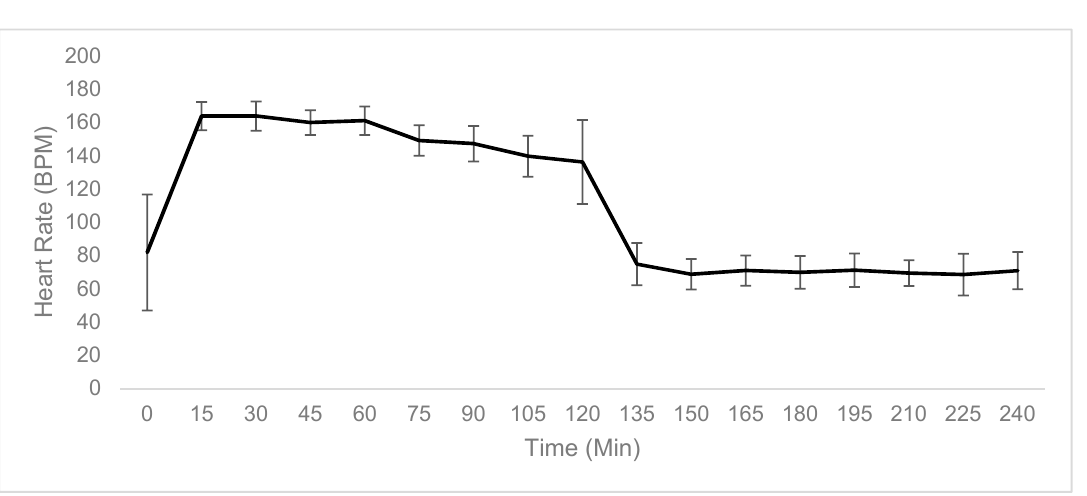
Figure 1. Average heart rate recorded at 15-minute intervals during collection of breath samples. Small variations across subjects were observed during the exercise phases of the protocol. Upon rest, the average heart rate returned to the baseline and remained consistent across this phase.